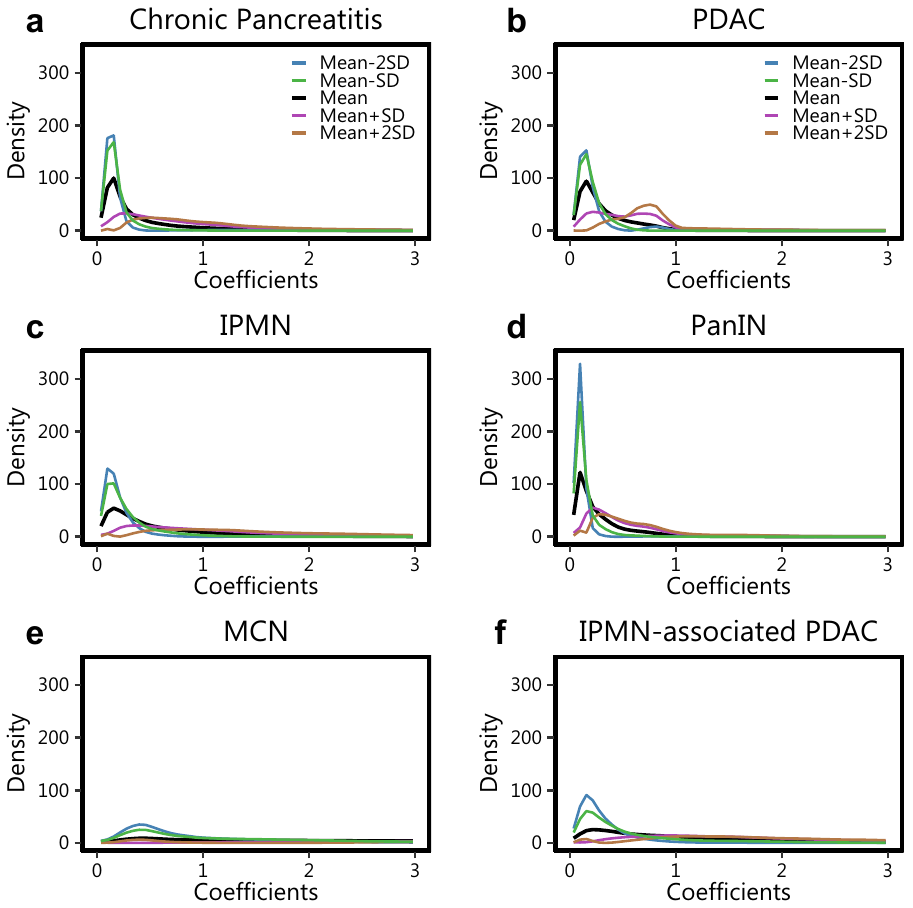
Figure 3. The first principal direction of variability for all images in each of the disease cohorts. In each case we present the path sampled with standard deviations around the Karcher Mean of each disease cohort along the first principal component direction after dimension